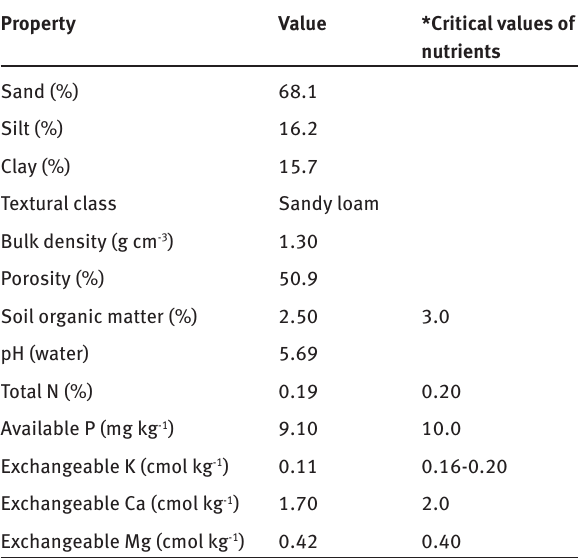
Table 1: Initial soil characteristics at Owo in 2017 before experimentation